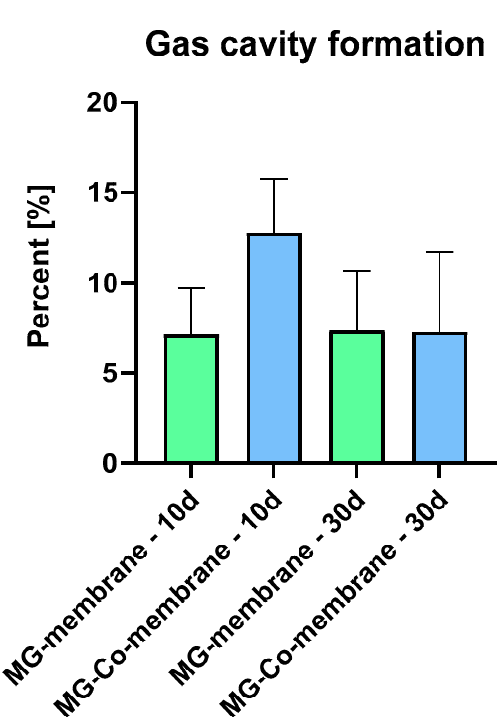
Figure 6. Histomorphometric results of the gas cavity formation in case of the analyzed magnesium- based membranes.